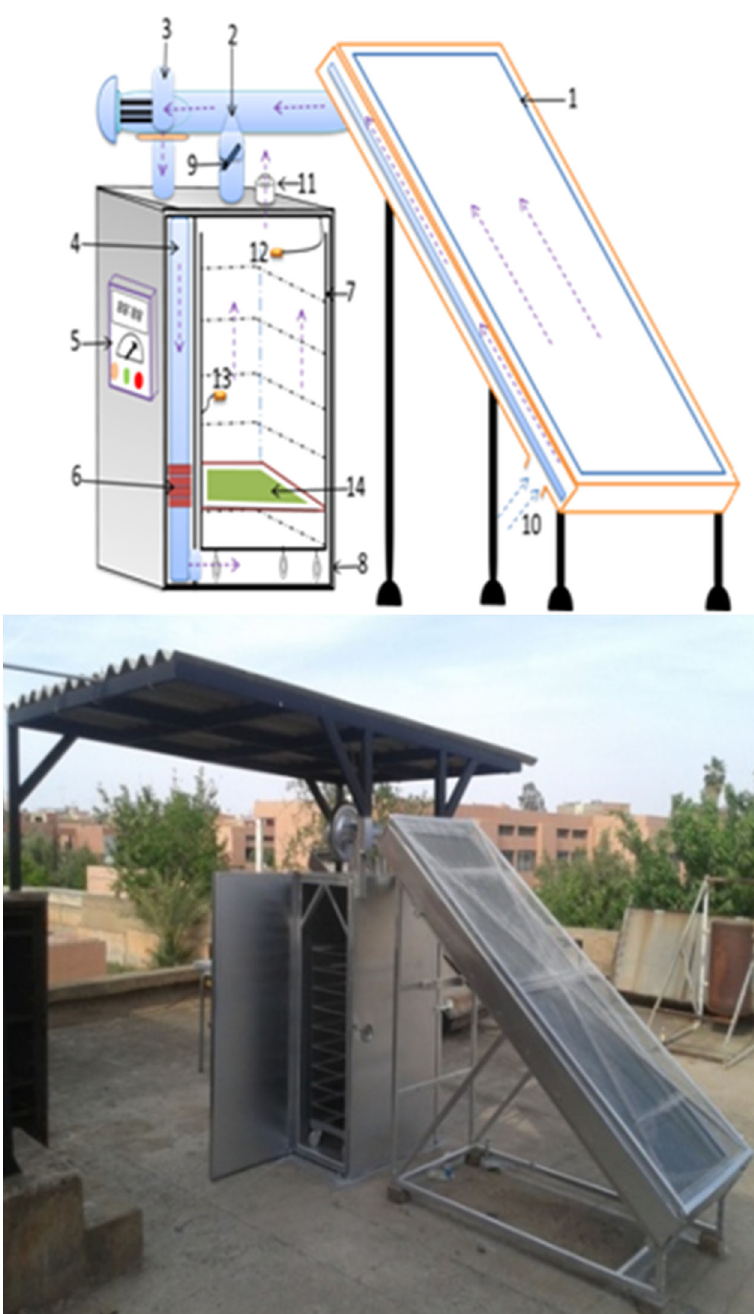
Figure 1. Design of the solar dryer. (1) Solar collector, (2) direction of the fan, (3) fan, (4) air flow direction, (5) control box, (6) auxiliary heating system, (7) floors, (8) drying cabinet, (9) air valve, (10) inlet air, (11) outlet air, (12) humidity probe, (13) thermocouple and (14) drying tray.